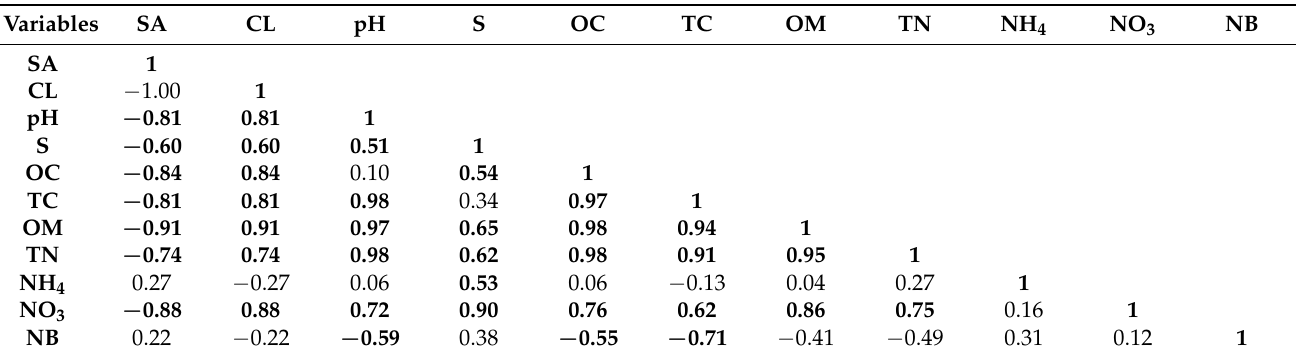
Table 4. Pearson’s correlation coefficient (r) matrix analysis shows the relationship among maize rhizosphere environmental factors.